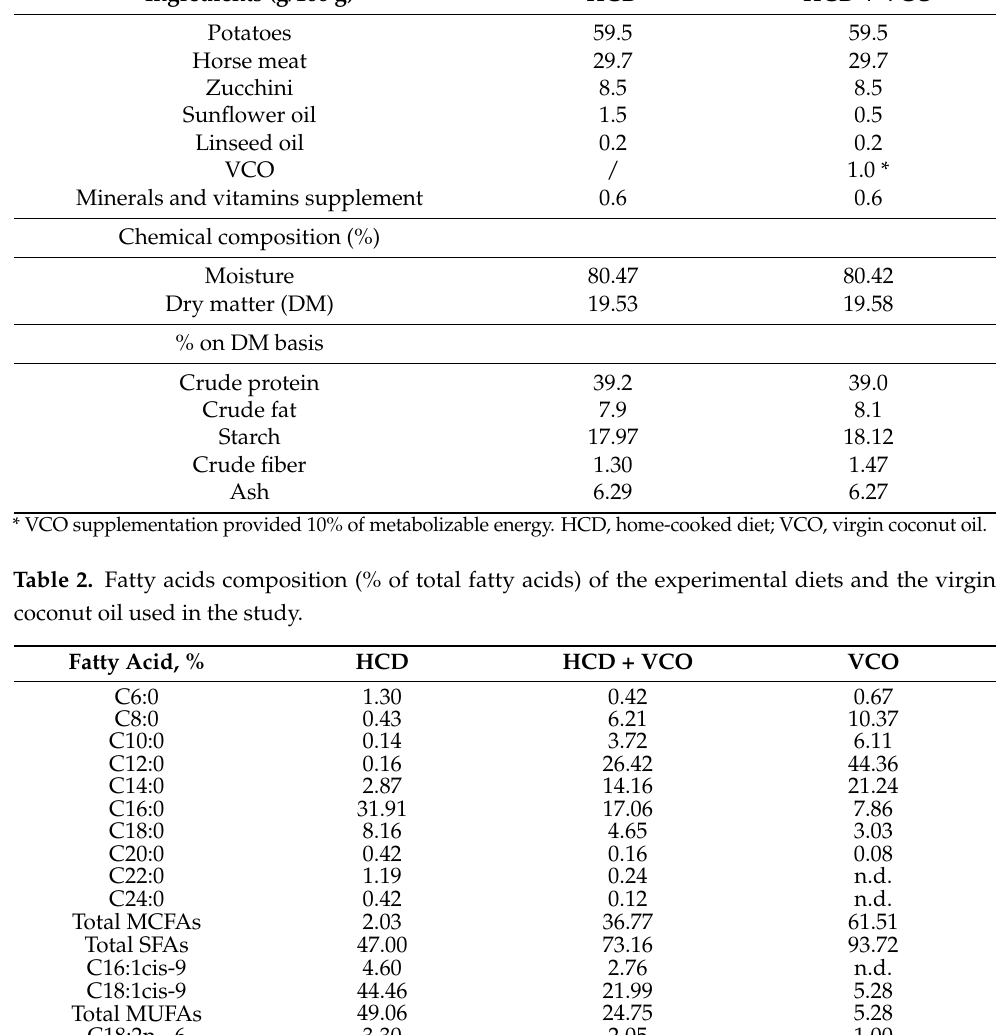
Table 1. Ingredients and chemical composition of the experimental diets fed to CE dogs. Ingredients (g/100 g)